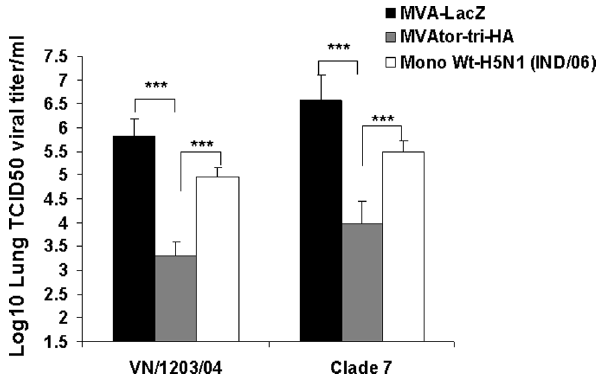
Figure 5. Virus titers in mouse lungs of experimentally infected with clade 1 or clade 7 H5N1 strain. Each group of mice was immunized i.m. two times on days 0 and 28 with MVAtor-tri-HA or MVAtor-mono-HA (A/Vietnam/1203/04) or MVA-LacZ vector. Three weeks after the second vaccination, mice were intranasally infected with 10 MLD 50 of a clade 1.0 (RG-A/Vietnam/1203/04) or clade 7.0 (RG- A/chicken/Shanxi/2/2006) H5N1 strain. The viral loads were measured in the lungs of the infected animals on day 3 post challenge. The results are expressed in terms of mean value of log TCID 50 /mL 6 standard deviation (SD). The lower limit of detection was 1.5 log 10 TCID 50 /mL. (**P , 0.01; ***P , 0.001). neutralizing antibody titers against homologous H5N1 strains (1:905 against A/Vietnam/1203/04, 1:1040 against A/Indone- sia/CDC669/06 and 1:790 against A/Anhui/01/05) compared to mice immunized with MVAtor-mono-HA vector (A/Vietnam/ 1203/04) or monovalent inactive H5N1 (A/Indonesia/CDC669/ 06) vaccine. Importantly, mice immunized with MVAtor-tri-HA vector showed cross-neutralizing antibodies against different clades of H5N1 strains (1:735 against clade 4, 1:780 against clade 7 and 1:905 against clade 9) (Fig. 3B). In contrast, mice immunized s.c. with monovalent inactive whole H5N1 vaccine developed a neutralizing antibody response against homologous H5N1 strain (1:280), but inactive H5N1 vaccine did not induce efficient neutralizing antibody response against heterologous clades of H5N1 strains (Fig. 3B).